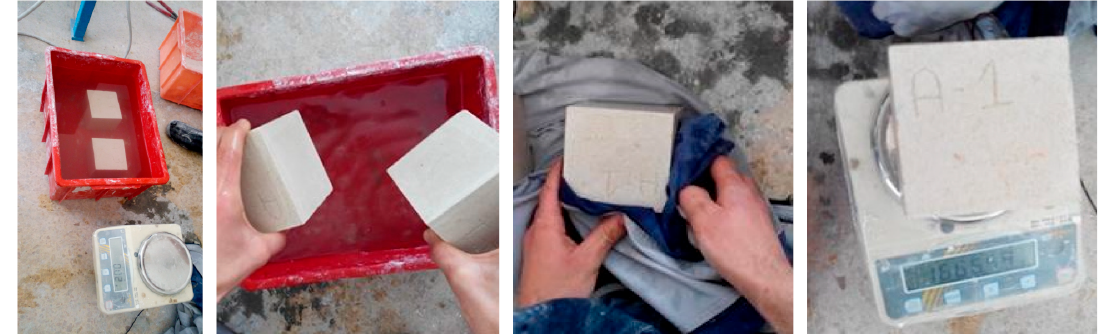
Figure 8. Measurement of specimen absorption degree.